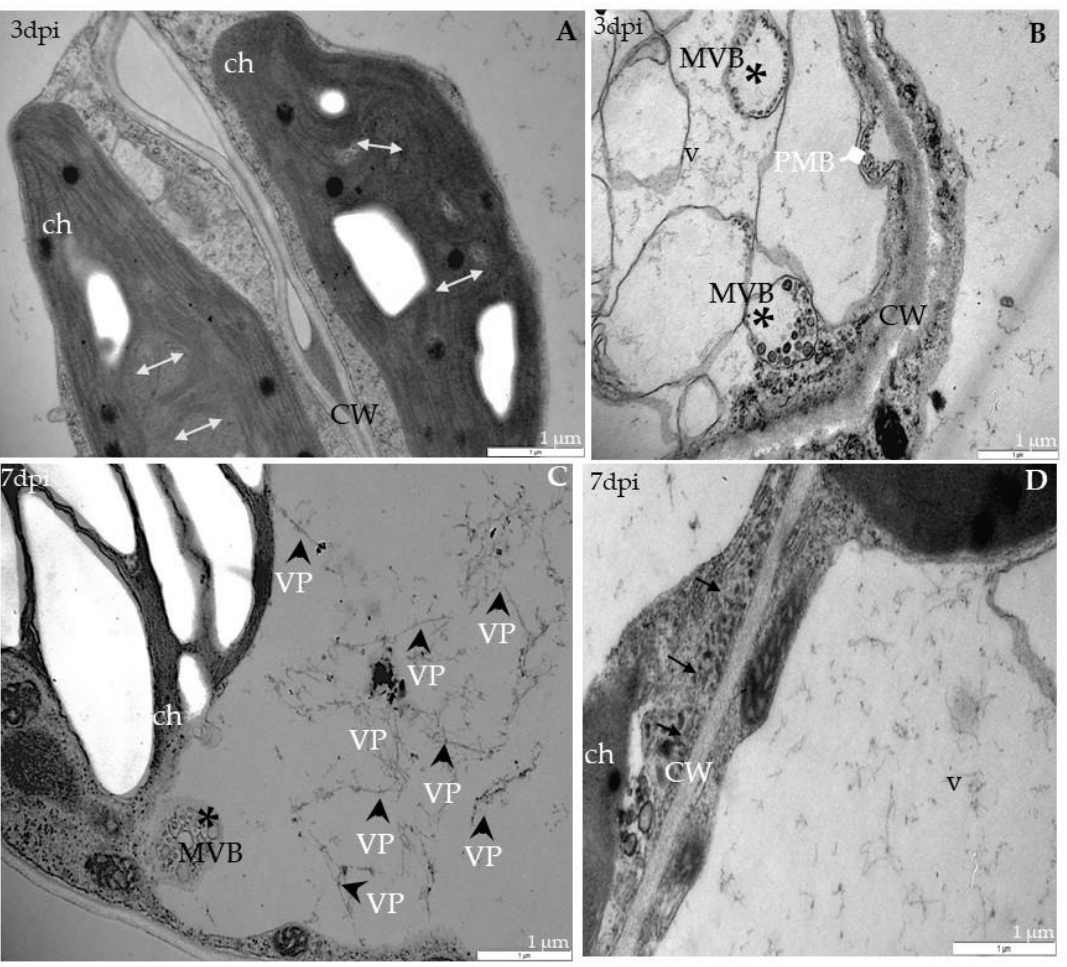
Figure 4. Curved structure of chloroplast lamellae stacks—multivesicular structures and viral particles in vacuole in different leaf tissues of rbohF plants 3 ( A , B ) and 7 days ( C , D ) after TuMV inoculation examined under a TEM. ( A ) Curved thylakoids (double-headed arrow) in chloroplast (ch) of palisade mesophyll cell. ( B ) Multivesicular structures (“single membranes with tubules”) (MVB; *) in vacuole (v) and paramular bodies (PMBs; marked by diamond head arrow) in phloem apoplast area. CW—cell wall. ( C ) Virus particles (VPs; arrowhead) and multivesicular bodies (MVB; *) inside vacuole (v) of spongy mesophyll cell. ch—chloroplast. ( D ) Irregular structure (arrows) of the cell wall (CW) between spongy mesophyll cells. ch—chloroplast; v—vacuole.